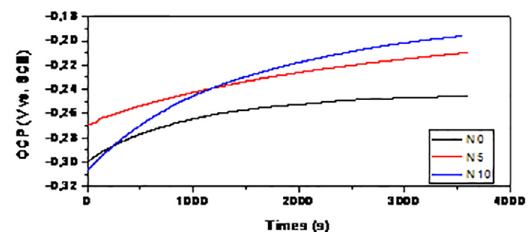
Figure 5. OCP curves of N0, N5 and N10 alloys.